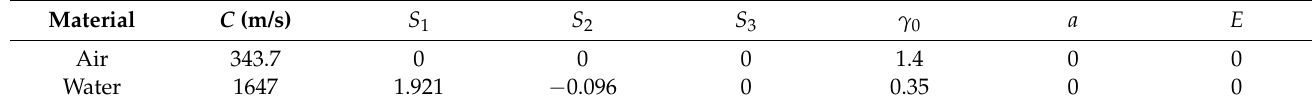
Table 2. Coefficients of the Grüneisen EoS for water and